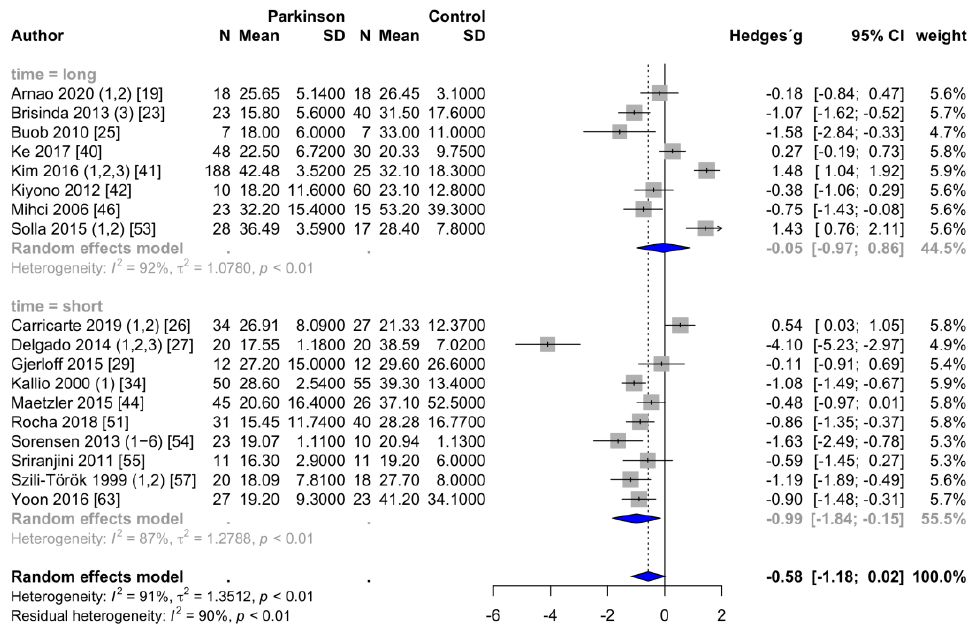
Figure 6. Forest plot RMSSD, subgroup measurement time.